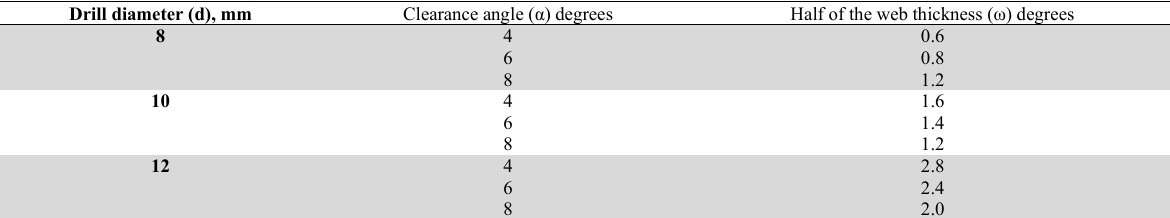
Geometry of chisel edge Drill diameter (d), mm